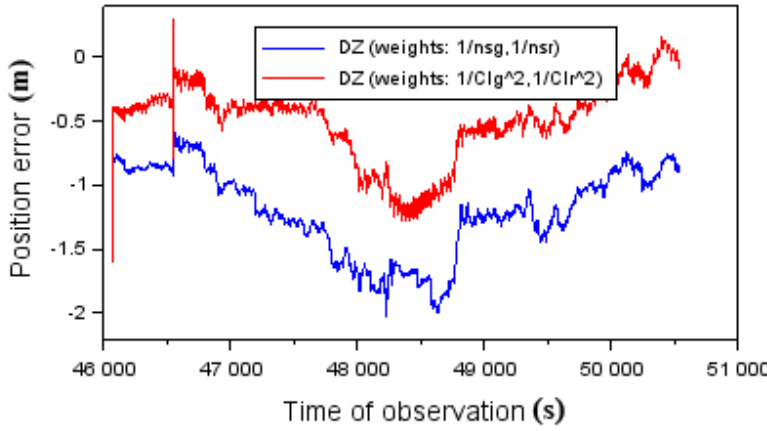
Figure 18. Position errors along the Z -axis .